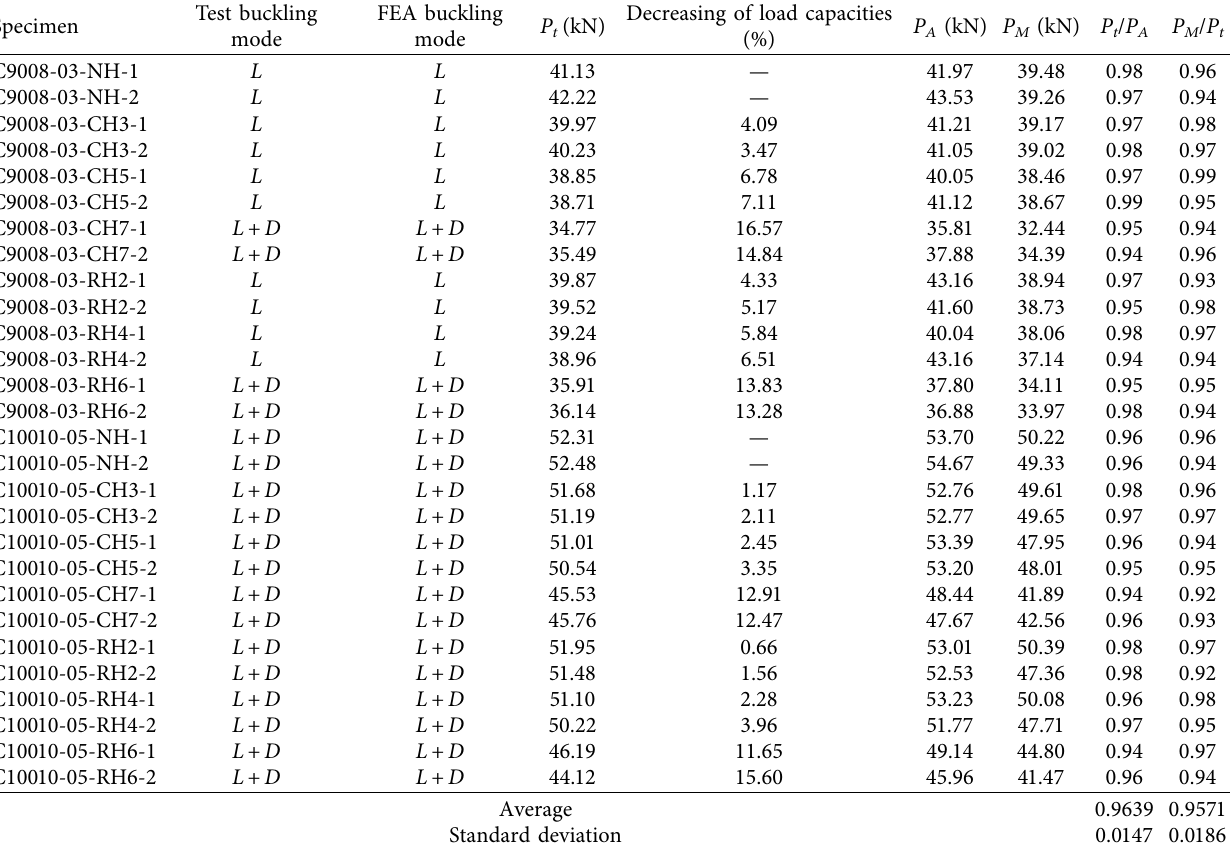
Table 4: Comparison of buckling modes and ultimate capacities of stud columns with